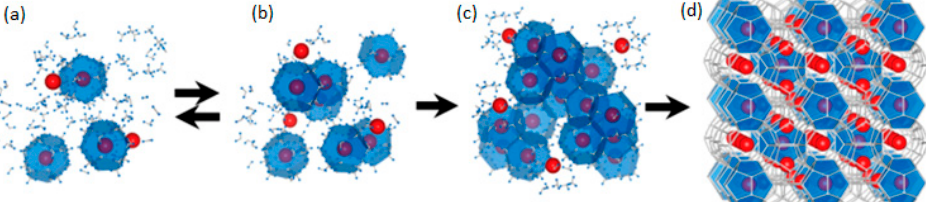
Figure 1. Labile cluster model of hydrate nucleation: ( a ) labile clusters, ( b ) agglomeration of clusters, ( c ) primary nucleolus, and ( d ) hydrate crystal. Reprinted from Ref. [32].